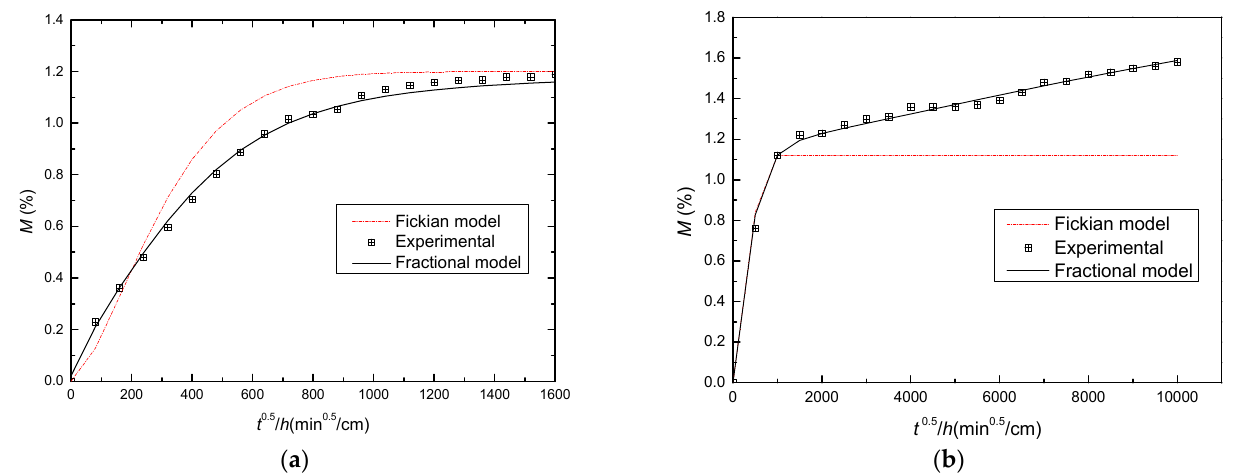
Figure 5. The comparison between experimental results and the fractional model by Equation (10) of the weight gain curve of a 3D woven composite during hygrothermal aging at 60 °C and 100%RH. The dash dot lines are Fickian diffusion. ( a ) Short-term moisture diffusion. ( b ) Long-term moisture diffusion. Table 3. Moisture diffusion parameters for 3D woven composite.